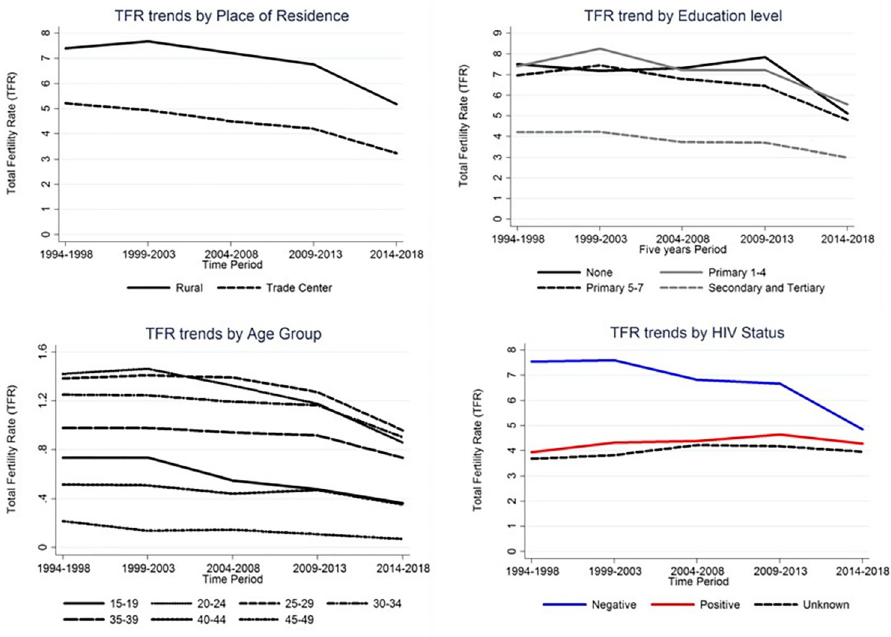
Fig 1. TFR by demographic characteristics. TFR by Place of residence (1994–2018). TFR by Place of Education (1994–2018). TFR by Age Groups (1994–2018). TFR by HIV status